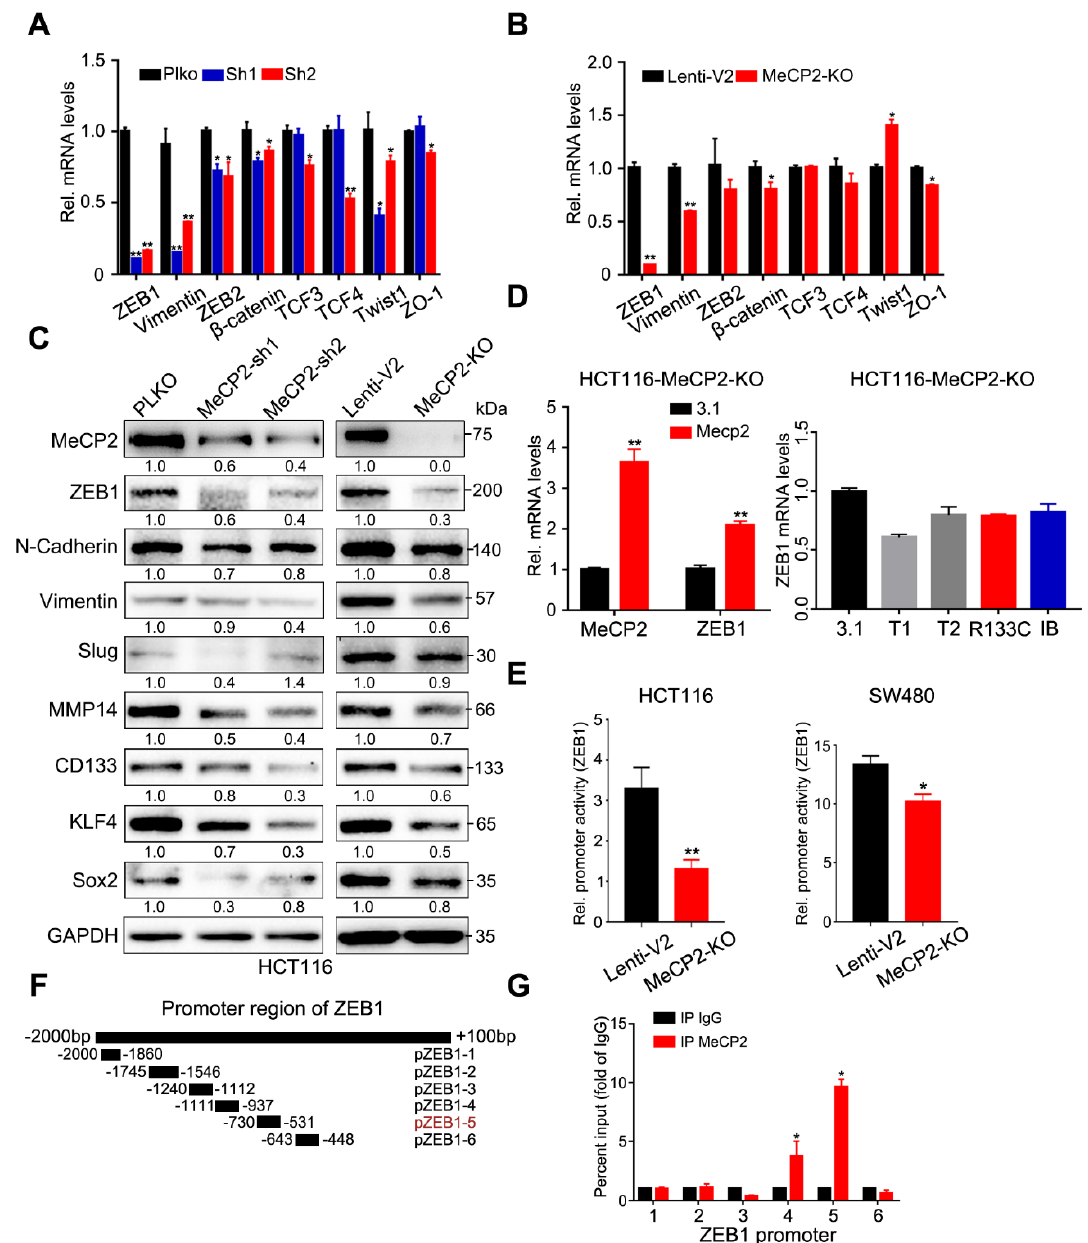
Figure 5. ZEB1 is the major e ff ector of MeCP2. ( A ) The mRNA levels of eight well-known epithelial to mesenchymal transition (EMT)-related genes in HCT116 cells with MeCP2 shRNA were examined by real-time PCR. ( B ) The mRNA levels of eight well-known EMT-related genes in HCT116 cells with MeCP2 sgRNA were examined by real-time PCR. ( C ) Western blot of EMT-related proteins in MeCP2-depleted cells. ( D ) The mRNA levels of MECP2 and ZEB1 were examined in MeCP2-knockout (KO) HCT116 cells after MeCP2 overexpression (left). The mRNA levels of ZEB1 were examined in MeCP2-knockout (KO) HCT116 cells after transfection with di ff erent truncation or mutation variants of MeCP2. ( E ) ZEB1 promoter activity. ( F ) Identification of the MeCP2 binding region on the ZEB1 promoter using deletion mutants. ( G ) HCT116 cells were subjected to chromatin immunoprecipitation using antibodies against MeCP2 and IgG.